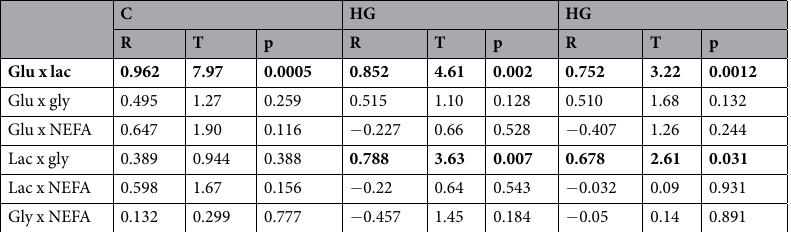
Table 2. Correlation between glucose (Glu) removal and lactate (lac), glycerol (gly) and NEFA accumulation in media from grey seal blubber explants (n = 10) incubated for 24 h in 5.5 mM glucose (C), 25 mM glucose (HG) or 5.5 mM glucose + 500 nM hydrocortisone (HC). Significant (p < 0.05) correlations are indicated in bold